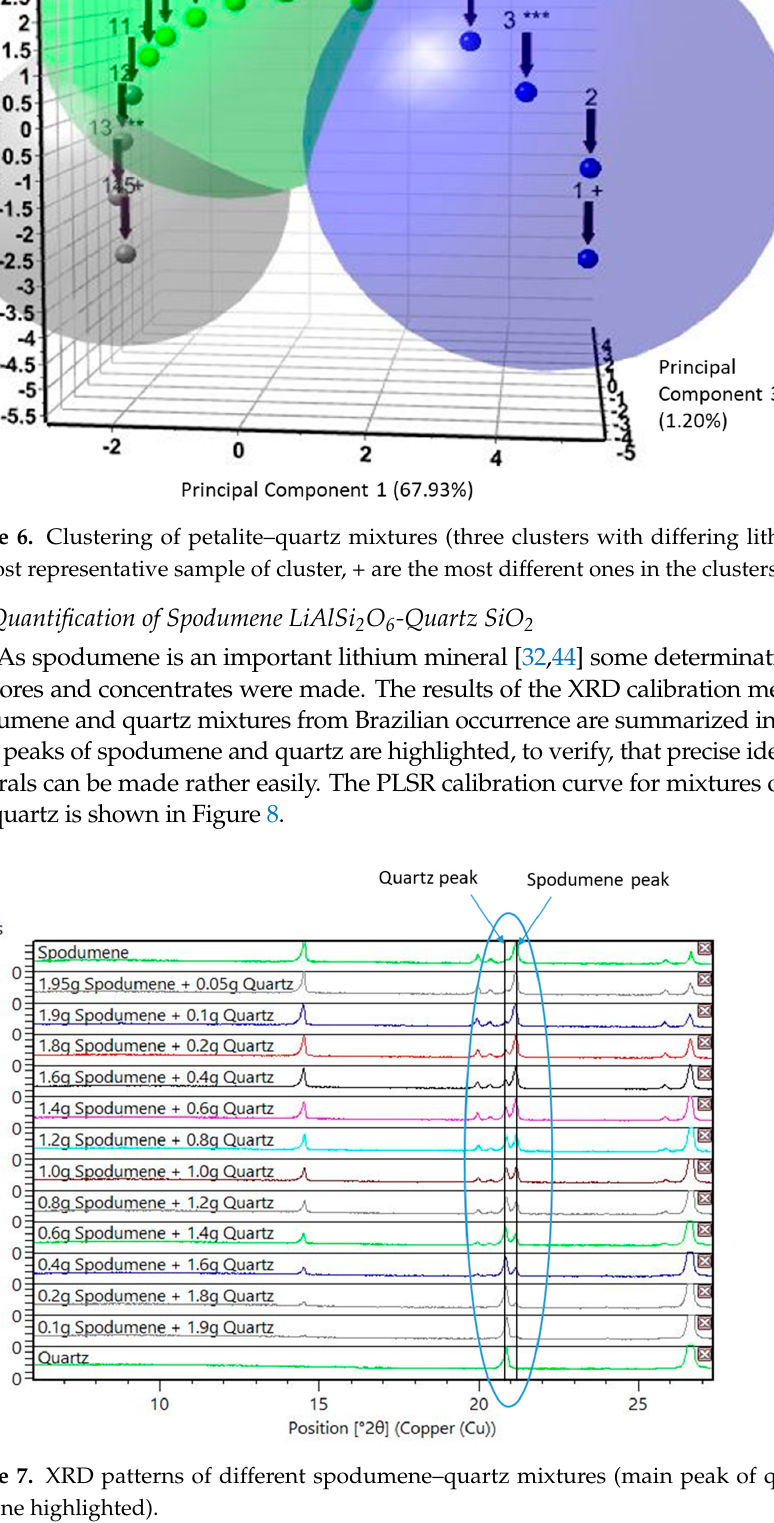
Figure 8. Calibration curve for spodumene–quartz mixtures. As an example for Rietveld refinement control of the different mixtures, the Rietveld plot for a mixture of 95% spodumene and 5% of quartz and the calculated composition is given in Figure 9.